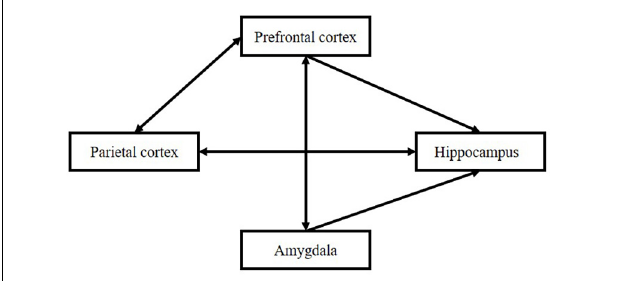
FIGURE 7 | Interactions among subregions of the